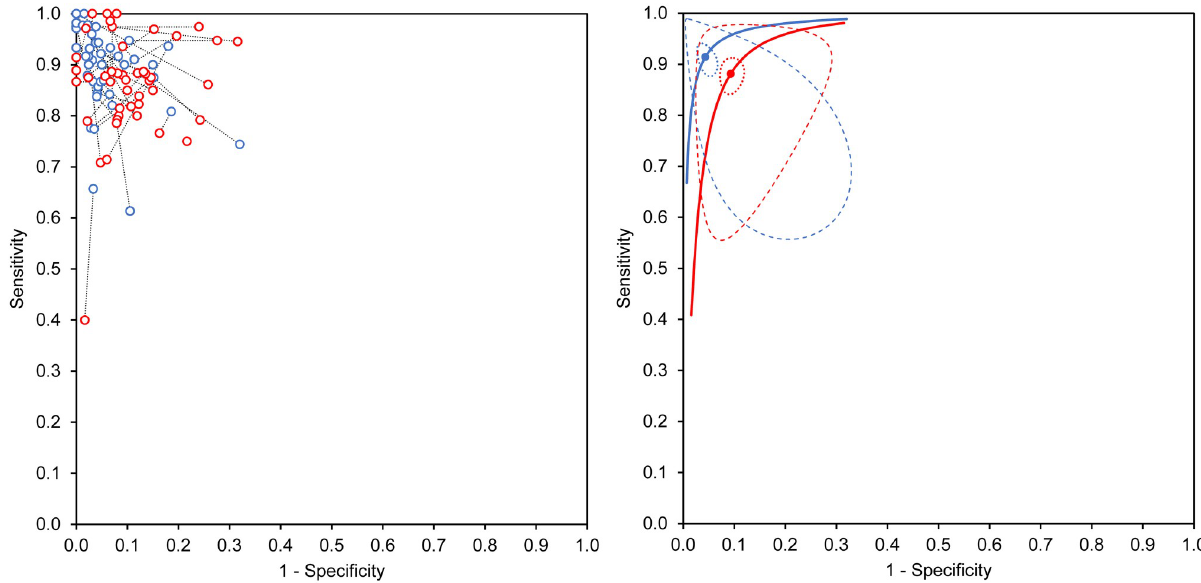
Fig 2. Comparison of summary points and summary curves, for studies evaluating both pleural fluid adenosine deaminase (red) and interferon- gamma (blue), in receiver operating characteristic (ROC) space. The left panel shows pairs of accuracy estimates from each included study, joined together by dotted lines. The right panel shows individual hierarchical summary ROC (HSROC) plots for the two tests, with the solid circles indicating the summary diagnostic accuracy points. The dotted ellipses represent 95% confidence regions around these summary estimates. The dashed lines represent the 95% prediction region (area within which one is 95% certain the results of a new study will lie).